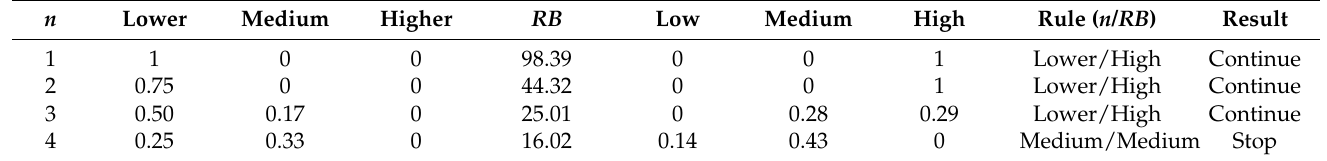
Table 4. Membership degree calculation and rules’